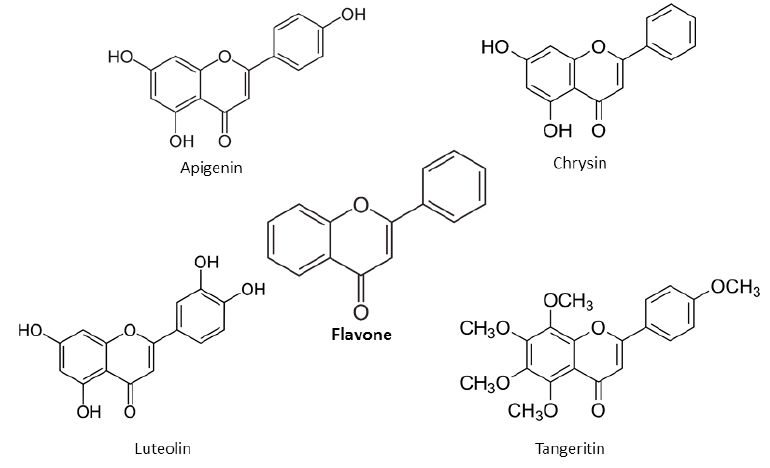
Figure 6. Chemical structures of main flavones.